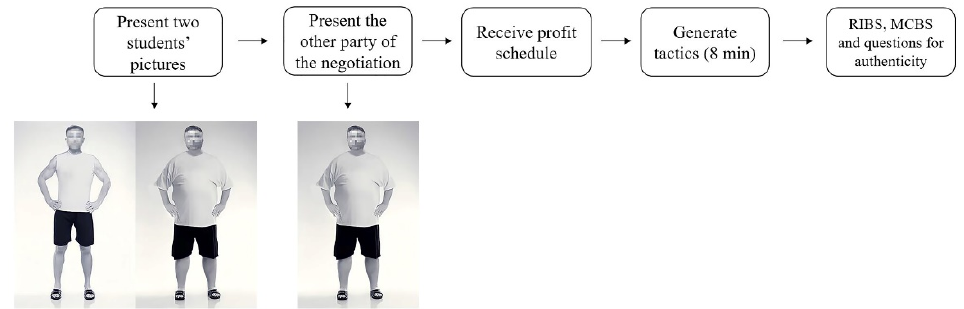
Figure 4. Procedure for male participants in Study 2.